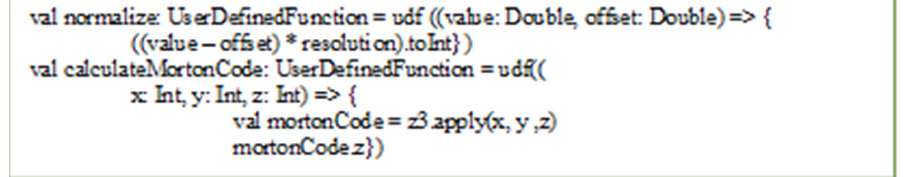
Figure 5. User define function ( UDF) over class point. ISPRS Int. J. Geo ‐ Inf. 2018 , 7 , x FOR PEER REVIEW